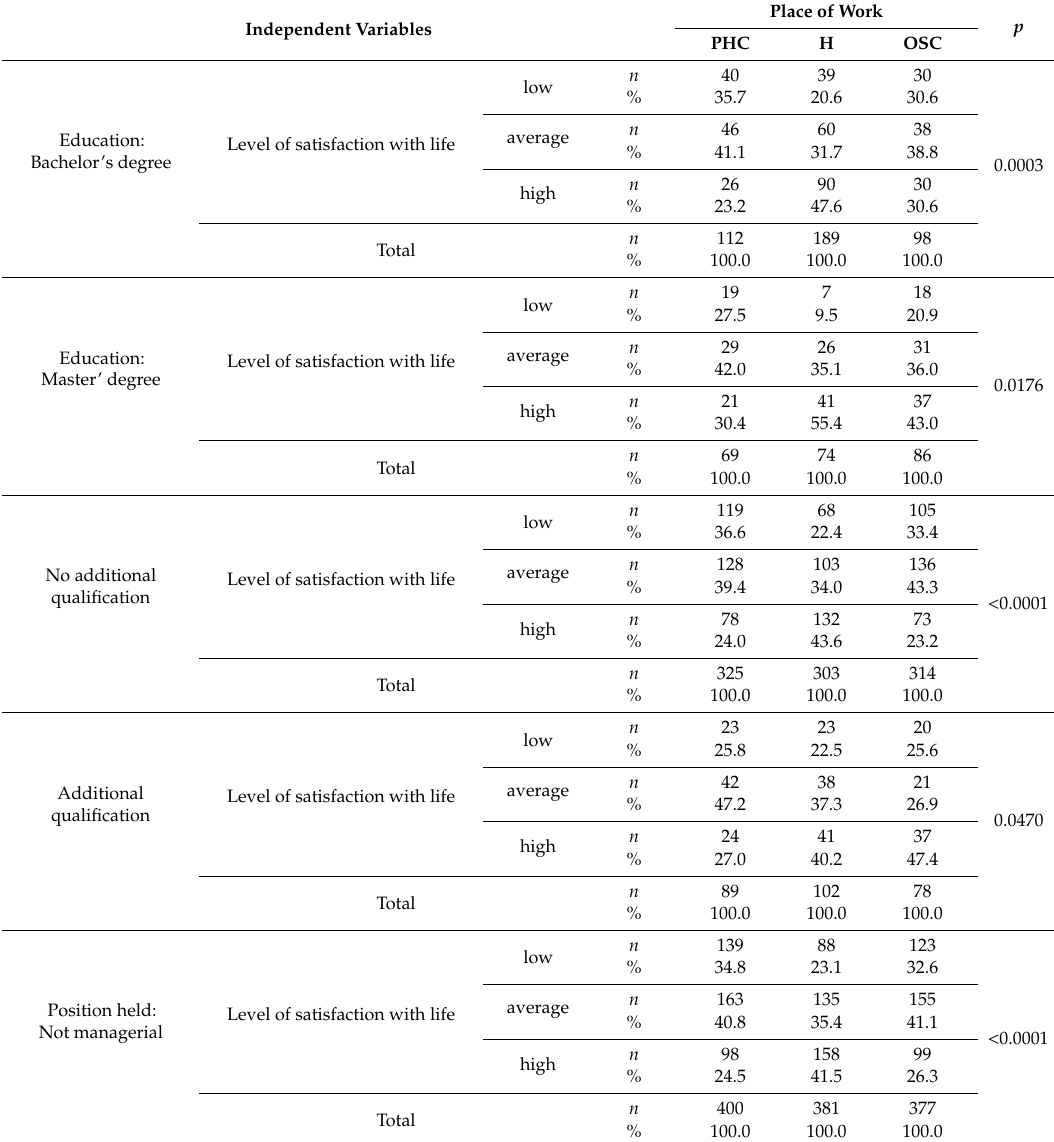
Table 4. Place of work and the level of life satisfaction depending on education, specialization, and position